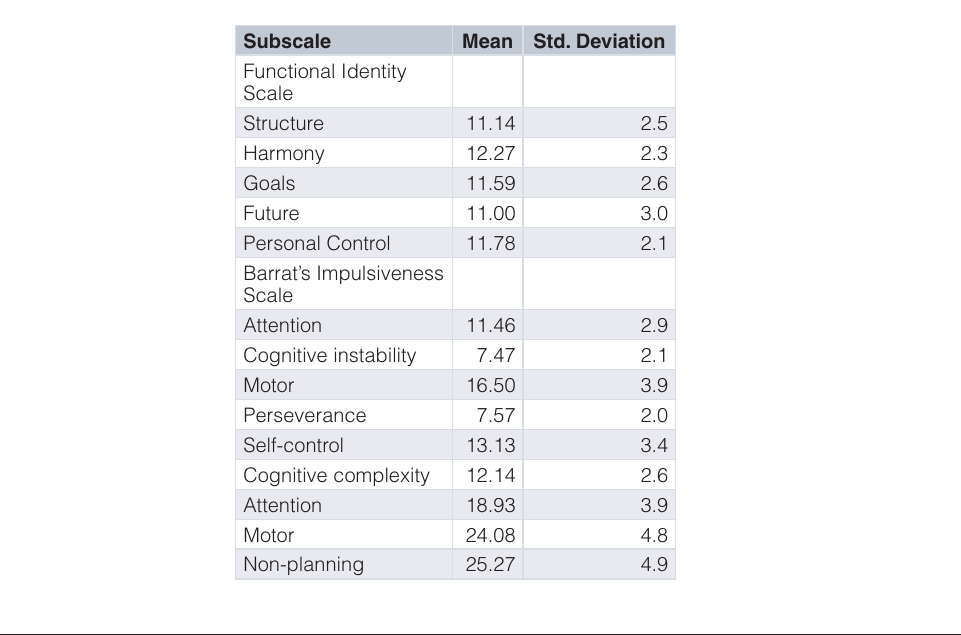
Table 1. Mean scores on subscales of the Functional Identity Scale.